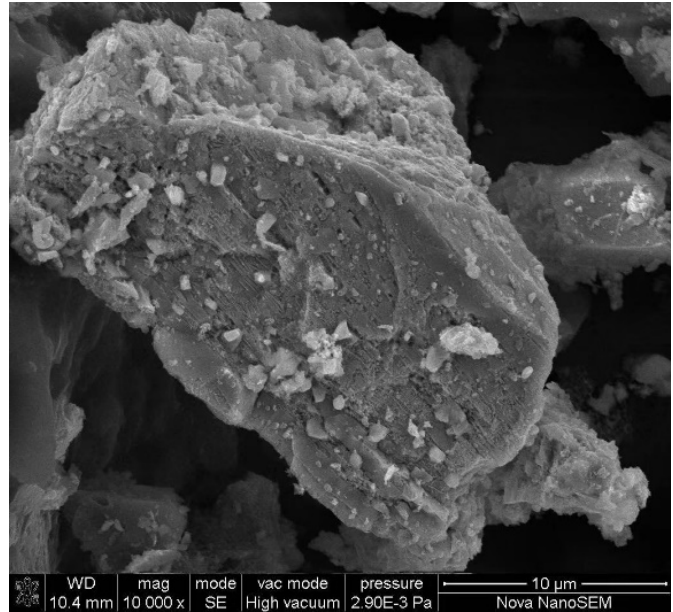
Figure 1. SEM image of the Newman ore before reduction.